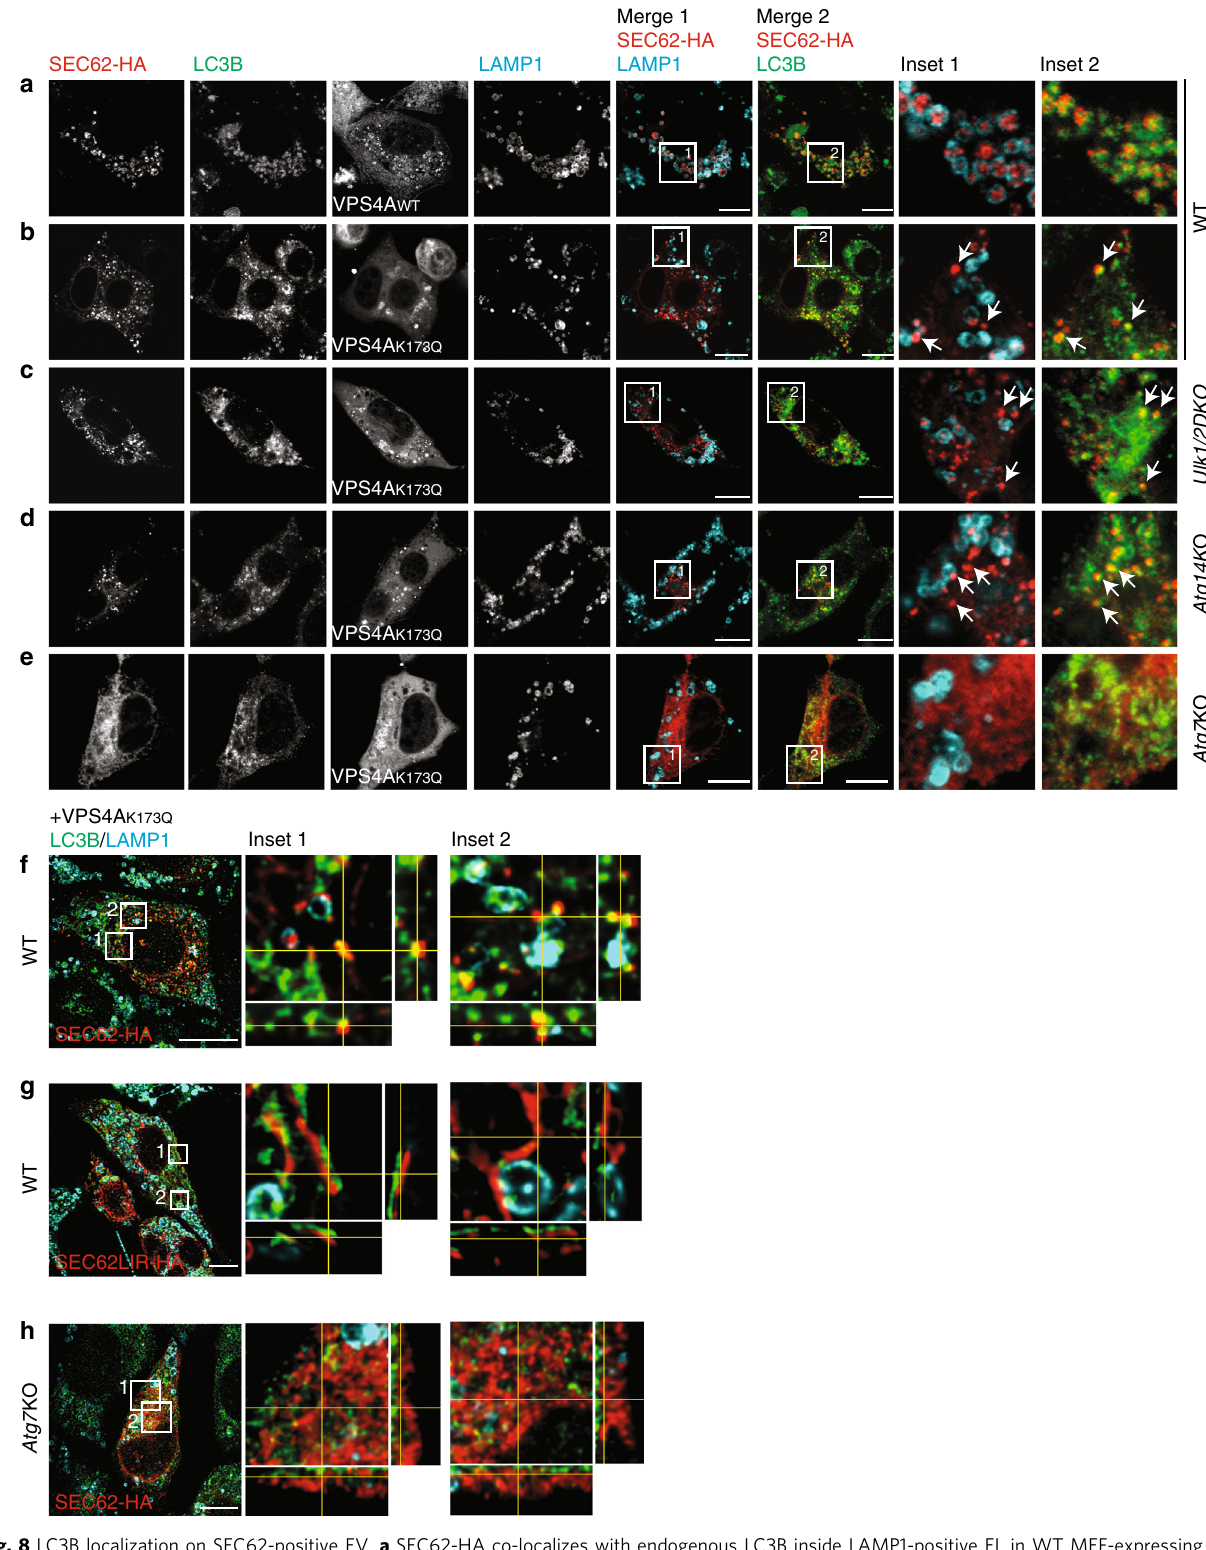
Fig. 8 LC3B localization on SEC62-positive EV. a SEC62-HA co-localizes with endogenous LC3B inside LAMP1-positive EL in WT MEF-expressing VPS4A WT exposed to BafA1 for 12 h. b SEC62-HA/LC3B-positive EV (white arrows) fails to be delivered inside the EL in WT MEF-expressing VPS4A K173Q . c Same as b in Ulk1/2 double-KO MEF. d Same as b in Atg14 KO MEF. e Same as b in Atg7 KO MEF. f Max projection of a WT cell expressing SEC62-HA and VPS4A K173Q after deconvolution. Insets show orthogonal sections of selected region. g Same as in f with SEC62LIR-HA. h Same as f in Atg7 KO MEF cells. Scale bars: 10 μ m. IF panels are representative of at least two independent